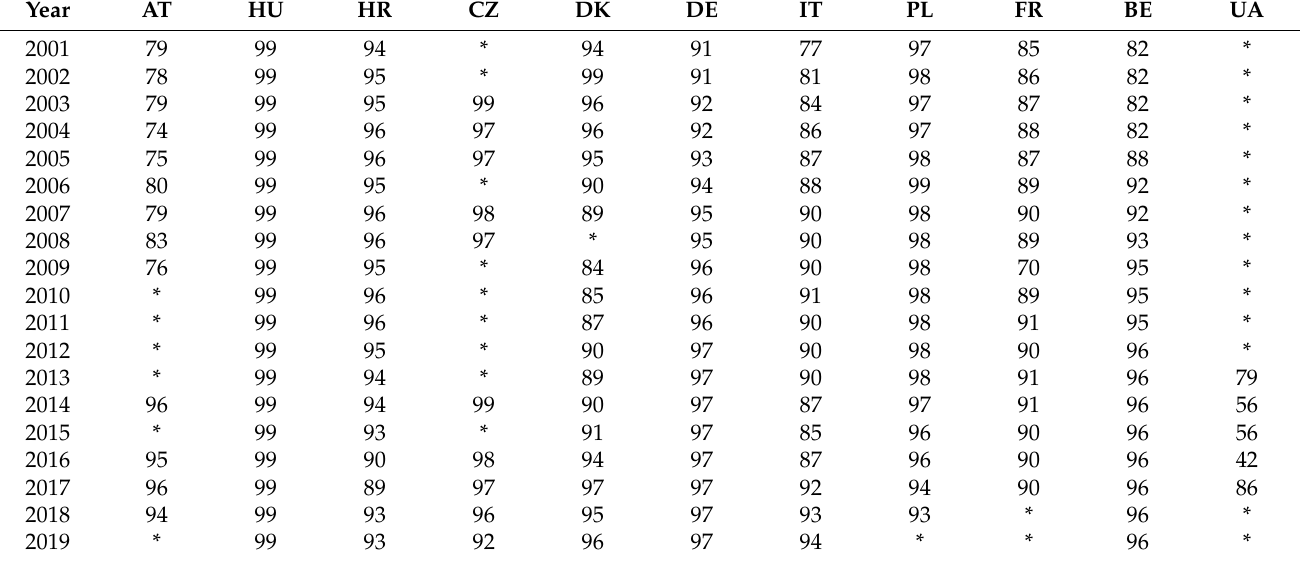
Table 5. Measles-containing vaccine 1st dose (%) in European countries from 2001 to 2019.